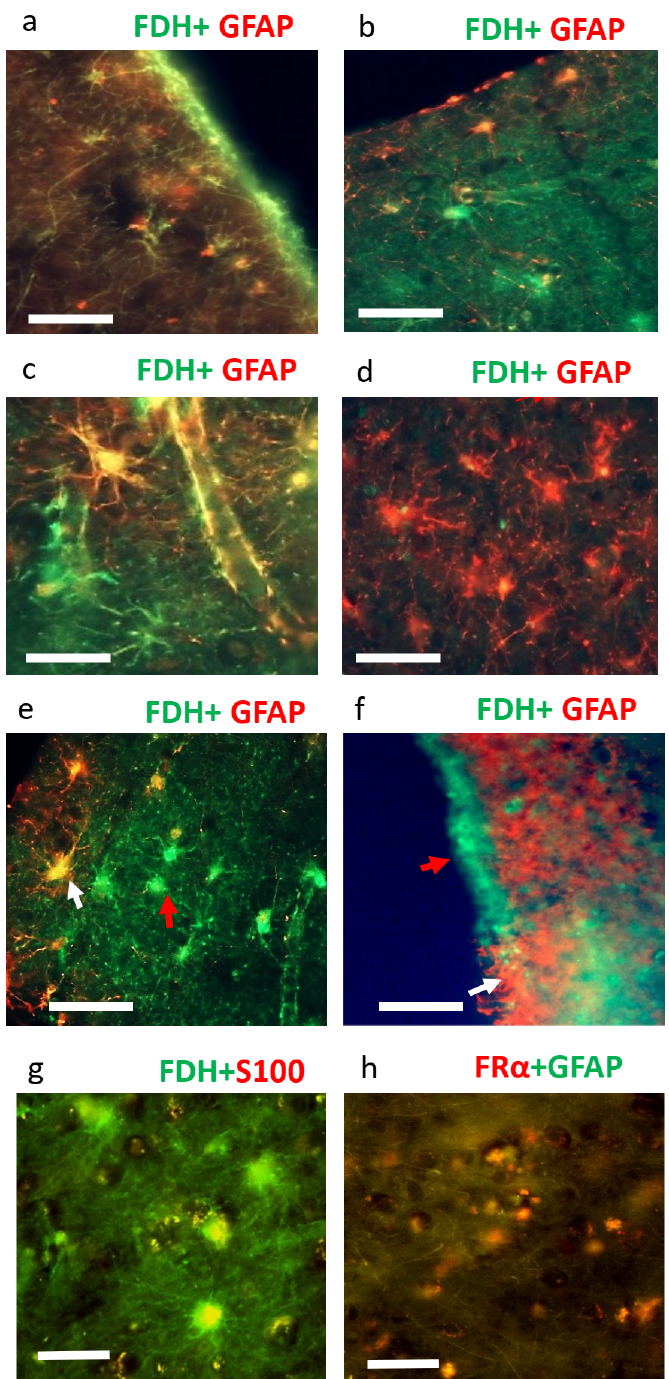
Figure 3. Immunofluorescence staining of Braak 0-II brain for FDH, GFAP, FR α and GFAP. Double immunofluorescence for FDH (green) and GFAP (red) staining of neurologically normal brain in cortical region near the pia mater ( a , b ) 100 × , scale: 100 µ m, white matter region ( c ), sub ventricular zone ( d ) and ventricular zone ( e , f ) at 200 × , scale: 50 µ m. The white arrows indicate FDH + /GFAP + whereas red arrow indicates FDH + /GFAP − . Double immunofluorescence staining of FDH (green) and S100 (red) ( g ) to demonstrate FDH + /S100 + astrocytes 200 × , scale: 50 µ m. Double immunoflu- orescence staining for FR α and GFAP ( h , 100 × ; scale bar 100 µ m). The figure is representative of n =